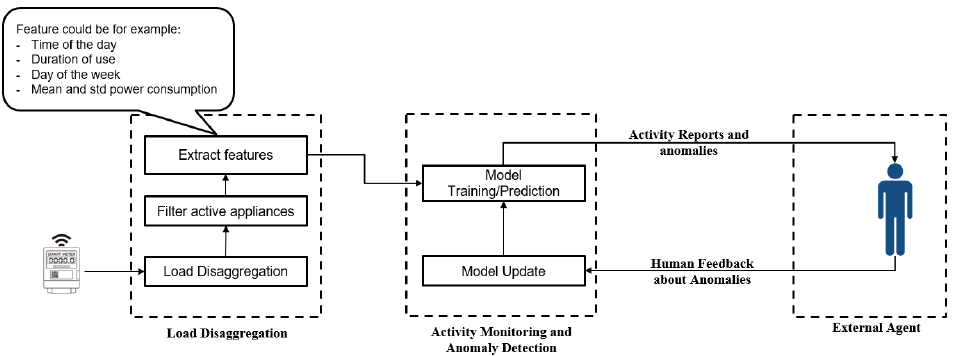
Figure 1. A general overview of the proposed